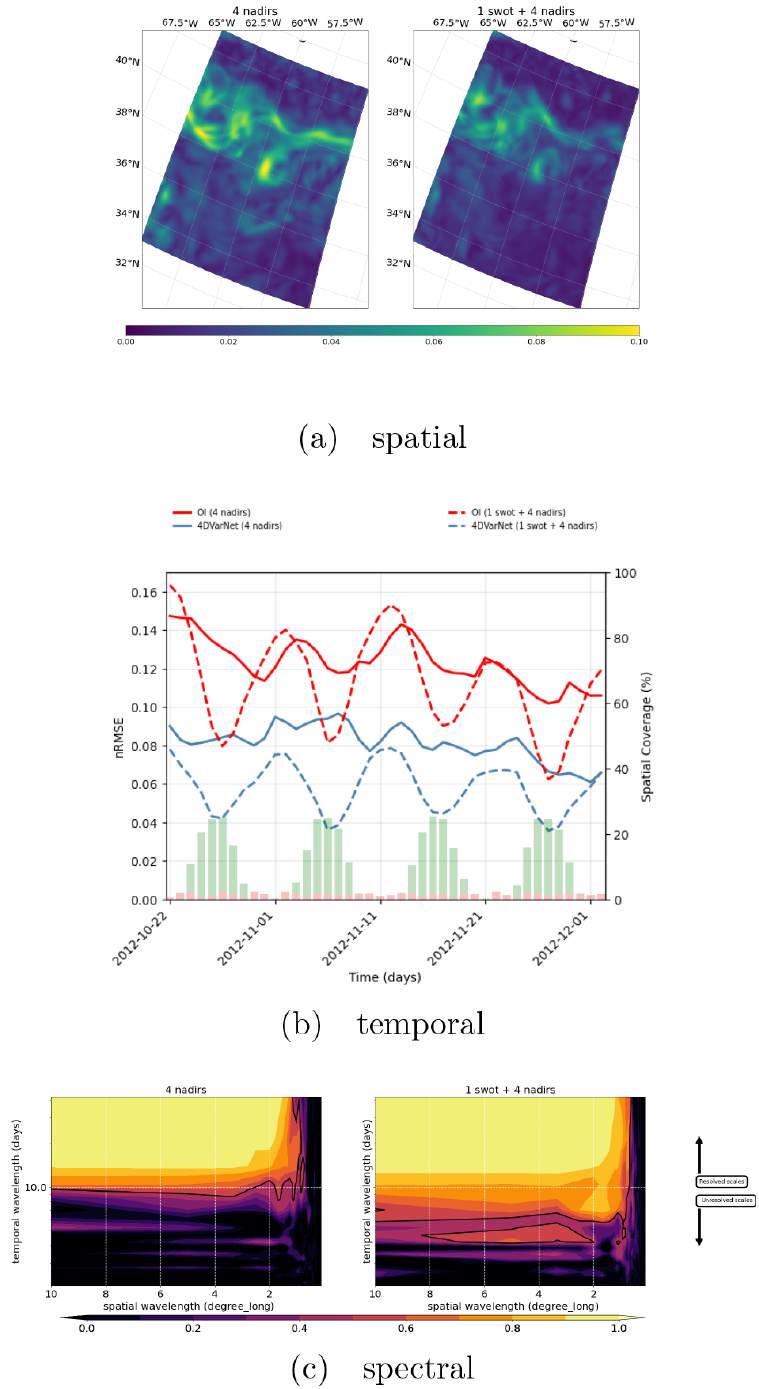
Figure 8. (a) Spatial performance, where the RMSE time series are computed for each spatial position of the GULFSTREAM domain (four nadirs on the left and one SWOT plus four nadirs on the right). (b) Temporal performance, where the RMSE daily GULFSTREAM maps are computed along the BOOST-SWOT DC evaluation period (four nadirs on the left and one SWOT plus four nadirs on the right), and the daily spatial coverage of the two configurations are given as complementary red and green bar plots scaled on the right-hand side. (c) Spectral performance, where the PSD-based score evaluates the spatiotemporal scales resolved in GULFSTREAM mapping (yellow area; four nadirs at the top and one SWOT plus four nadirs at the